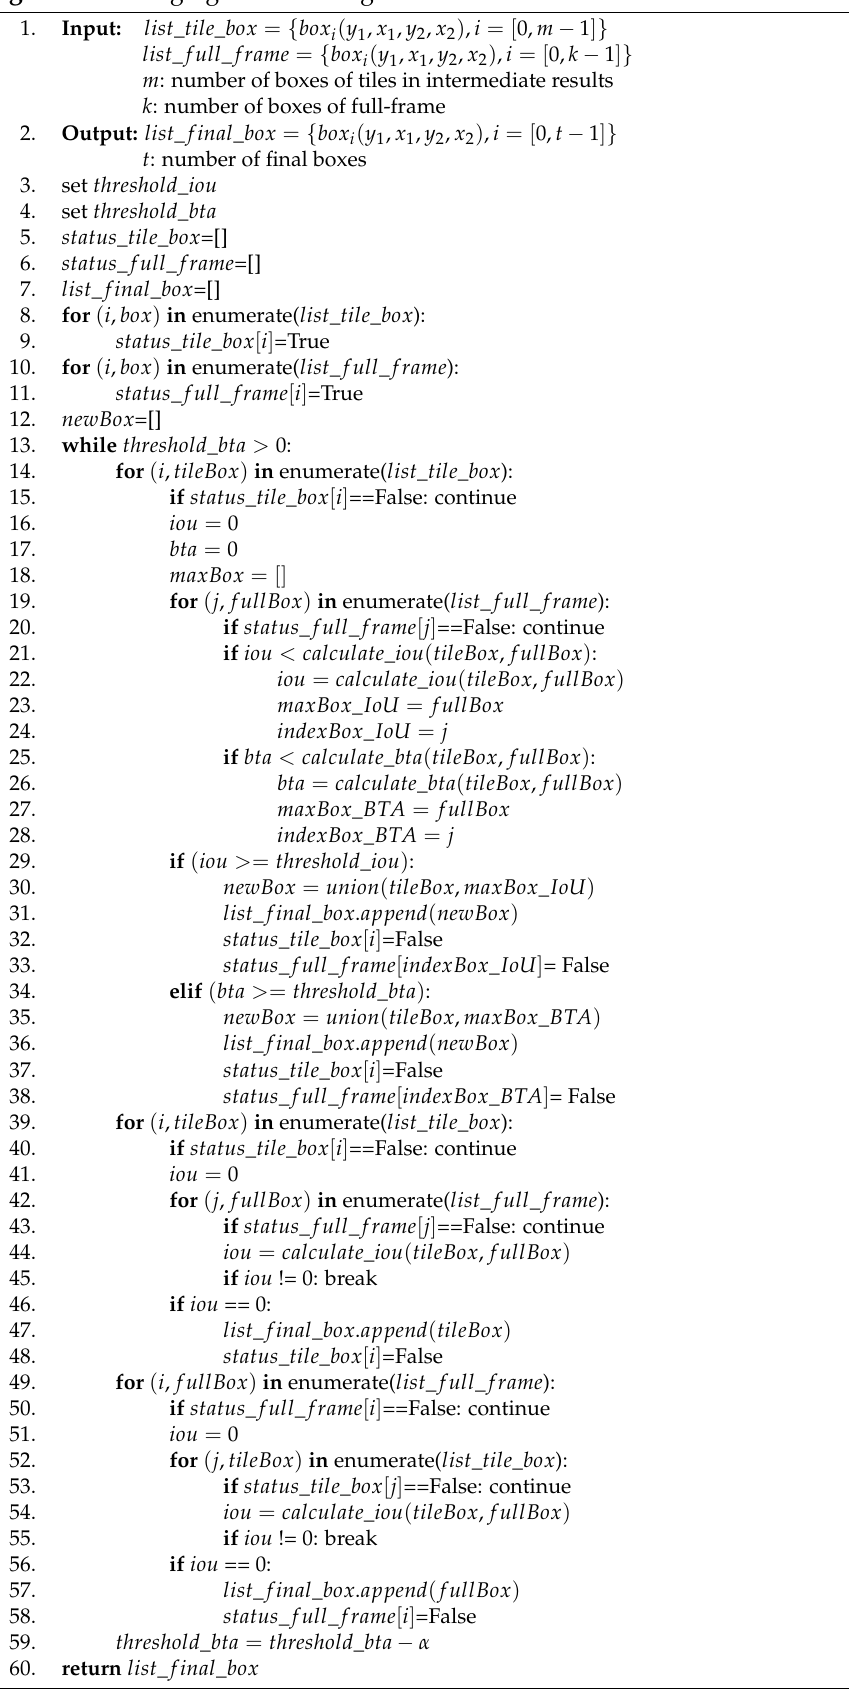
Algorithm 2 Merging the bounding boxes of intermediate results and